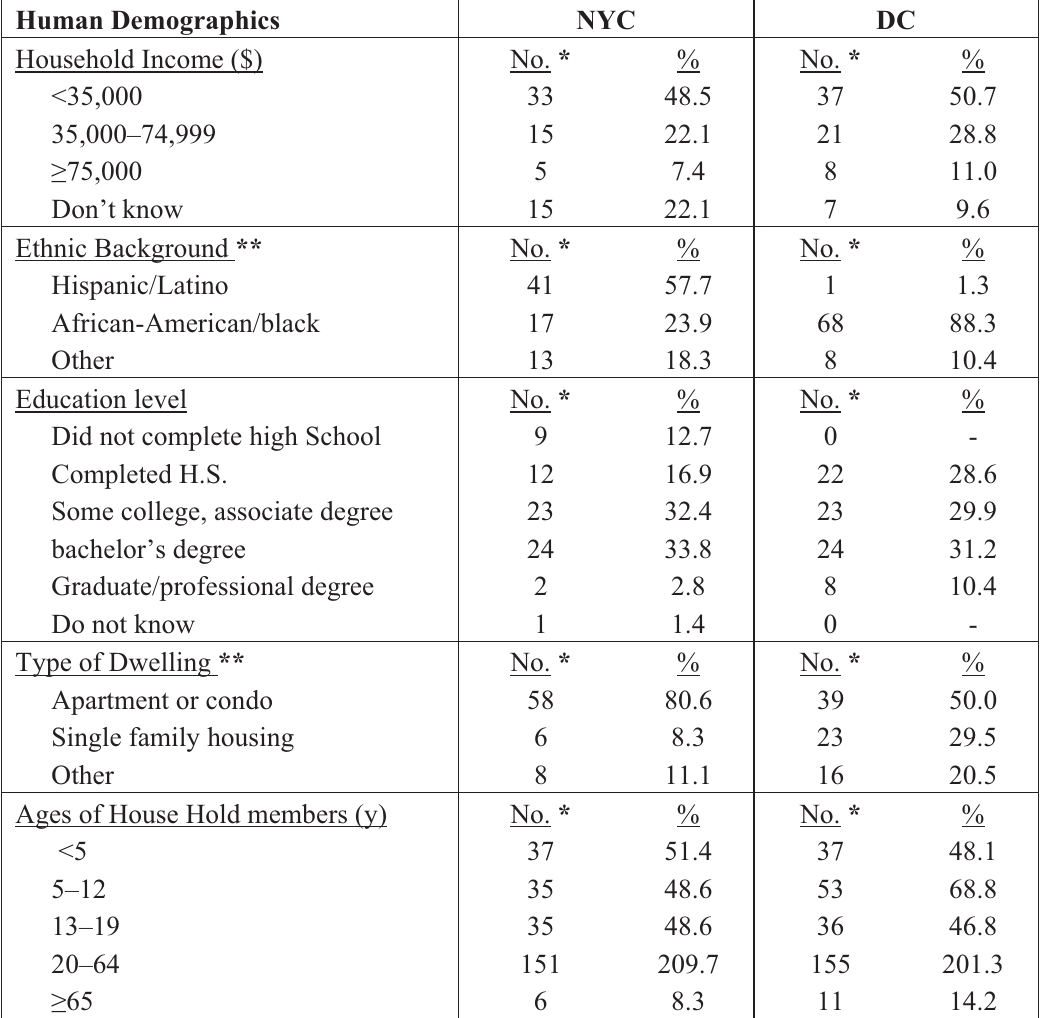
Table 1. Characteristics of respondents’ households in New York City (NYC) and Washington, D.C.